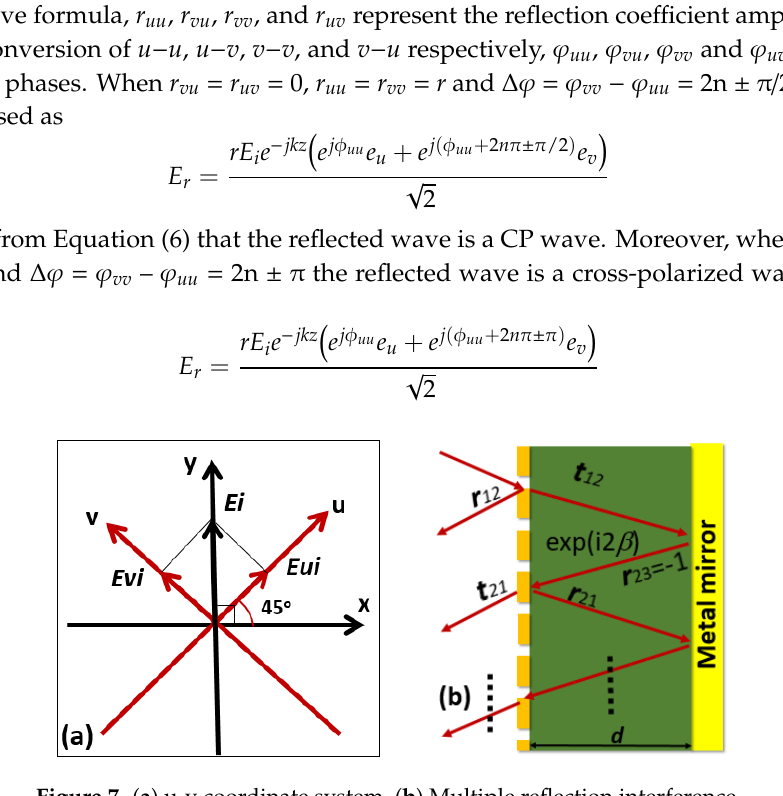
Figure 7. ( a ) u-v coordinate system, ( b ) Multiple reflection interference.